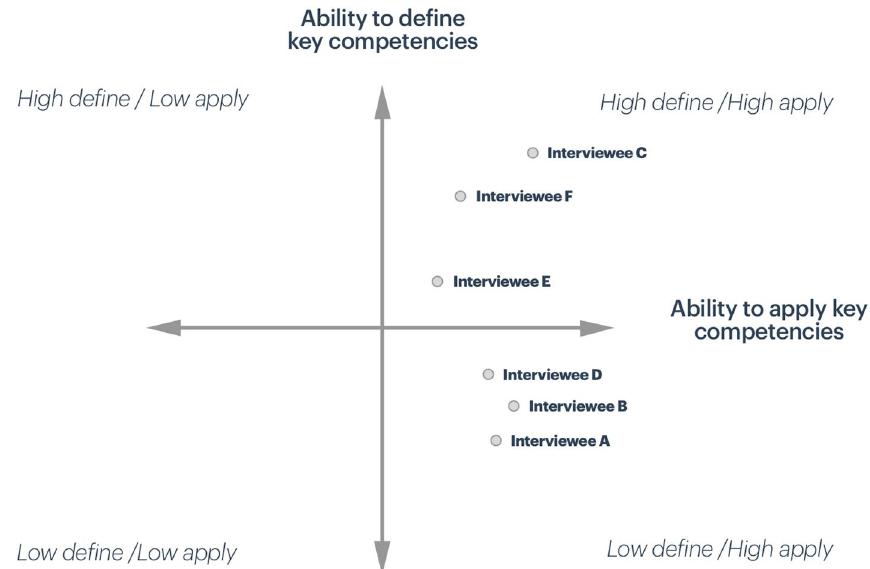
Fig. 4 Matrix showing interviewees’ ability to define ( x ‑axis) and apply ( y ‑axis) on key design thinking competencie